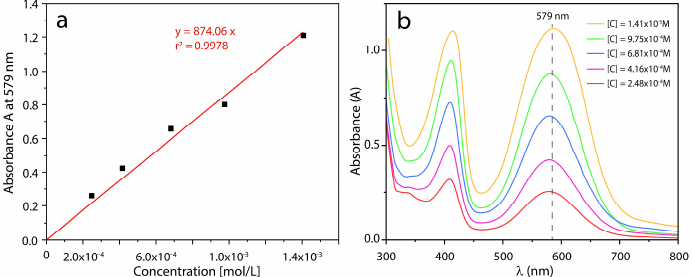
Figure 2. ( a ) Calibration curve; ( b ) absorption spectra of the different hexylamine solutions conducted by the Kaiser test. Kaiser tests were then conducted in the two samples bearing the unknown concen- tration of APTES, (i) APTES@SiO 2 (200 nm), and (ii) APTES@SiO 2 (50 nm) (Figure 2 and Scheme 2). The tests were performed as follows: (i) 60.2 mg of APTES@SiO 2 (200 nm) was suspended in 6 mL solution EtOH/ninhydrin (5:1) stirred for 90 min at 100 °C and the UV- Vis spectrum was recorded of the filtered solution (Figure 3, red); similarly (ii) 6.6 mg of the APTES@SiO 2 (50 nm) was suspended in 6 mL solution EtOH/ninhydrin (5:1) stirred for 90 min at 100 °C and the UV-Vis spectrum was recorded of the filtered solution (Figure 3, navy blue). The recorded Absorbance at λ = 579 nm for the Ruhemann’s purple were 0.60 and 0.66 respectively, which corresponds to concentrations of (C) APTES = 6.85 × 10 −4 M for APTES@SiO 2 (200 nm) and (C) APTES = 8.55 × 10 −4 M for APTES@SiO 2 (50 nm). Resulting in coverages of 69 μmol (APTES)/g SiO 2 and 780 μmol (APTES)/g SiO 2 respectively, we ob- serve a clear improvement in the grafting capacity of the nanoparticles, which was ex- pected as the effective surface per nanoparticle is four times larger and the surface energy is increased. Figure 3. Absorption spectra of APTES@SiO 2 (50 nm) and APTES@SiO 2 (200 nm) treated with nin- hydrin. 3.1.2. X-Ray Photoelectron Spectroscopy A XPS analysis of the SiO 2 (50 nm) nanoparticles before and after APTES adsorption was performed in order to confirm the success of the APTES grafting on the silica NPs. As presented in Figure 4, C 1s and N 1s core levels peaks were compared before (SiO 2 (50 nm)) and after (APTES@SiO 2 (50 nm))) APTES functionalization. XPS spectra of the N (1s) region (Figure 4, left) shows a remarkable increase of the nitrogen intensity after APTES functionalization process, deconvolution of the signal shows only one component at a binding energy of 400.5 eV, which is attributed to NH 2 groups [43,44], due to the chemical composition of the APTES molecule. A deconvolution